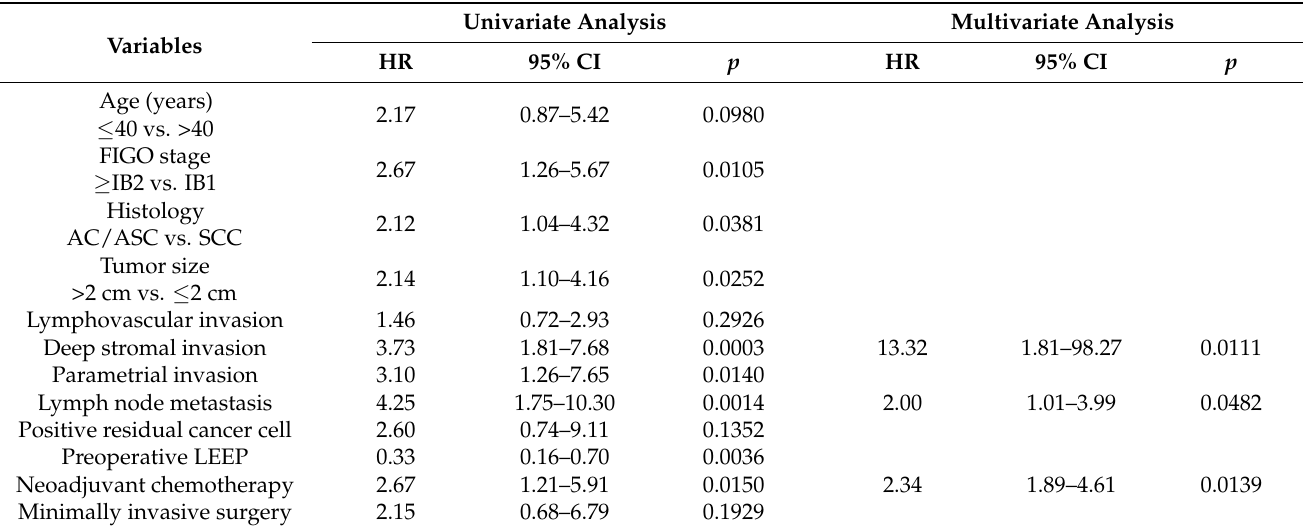
Table 2. Univariate and multivariate analyses of clinical variables for the prediction of tumor